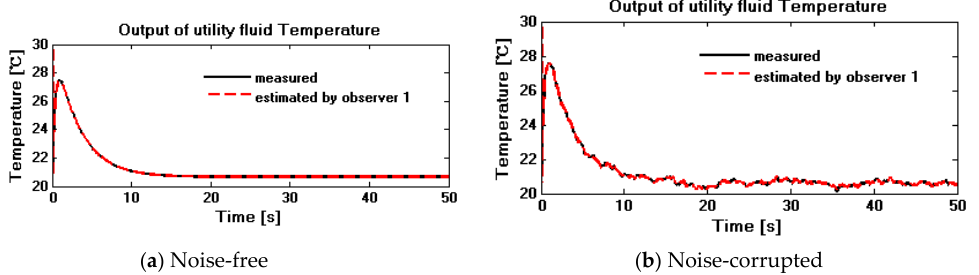
Figure 4. Output of the utility fluid temperature T u . The solid line is the measured value, and the dashed line is estimated by Observer 1. ( a ) represents Noise-free case while ( b ) represents Noise-corrupted case.